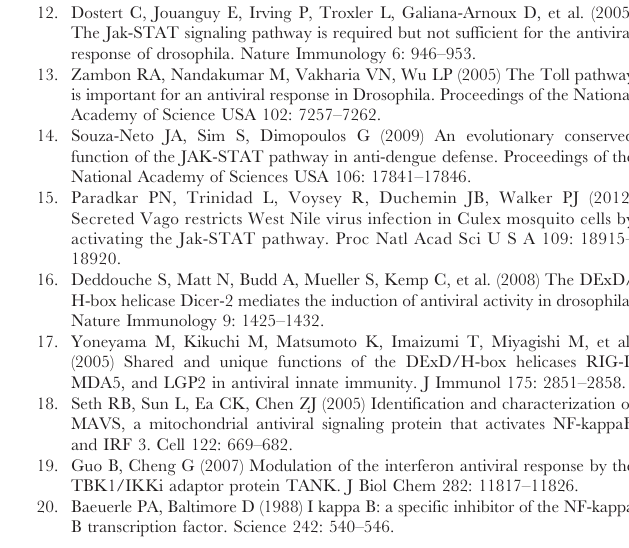
Figure S4 Hsu cells were transfected with dsRNA against Rel2 (or GFP). At 24 h post-transfection, the cells were infected with WNV. At 48 hpi total cell lysates were collected and Western blot was performed using anti-Vago antibody. Anti-beta actin antibody was used as an internal loading control. Representative blot shown here. (DOCX) Figure S5 Hsu cells were transfected with dsRNA against TRAF (dsRNA TRAF), TRAF-3 (dsRNA TRAF3) or control dsRNA (GFP) along with plasmid containing the Vago-Luciferase reporter (and firefly luciferase control plasmid). At 24 h post-transfection, the cells were infected with WNV and luciferase activity was measured at 24 hpi. The Renilla luciferase activity values were standardised using firefly luciferase activity values (R/F) and resulting values were plotted as bar graphs. Error bars represents standard error from experiment with assays performed in triplicates (Student’s t-test *p , 0.05) and values were compared with GFP transfected cells. Table S1 Transcription factor binding sites on Culex Vago promoter region predicted by PROMO software. Footprinter2.0 was used to predict sites conserved between Culex, Aedes and Anopholes promoters. The conserved sites are in bold. Table S2 List of primers used in the manuscript for real-time PCR detection and dsRNA